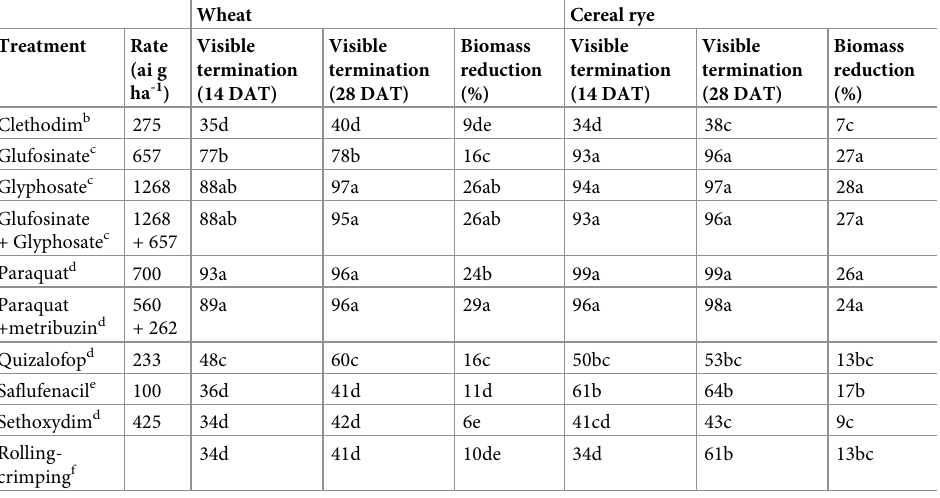
a Visible termination and biomass reduction means with a column followed by the same letter are statistically similar to each other at 5% level of significance